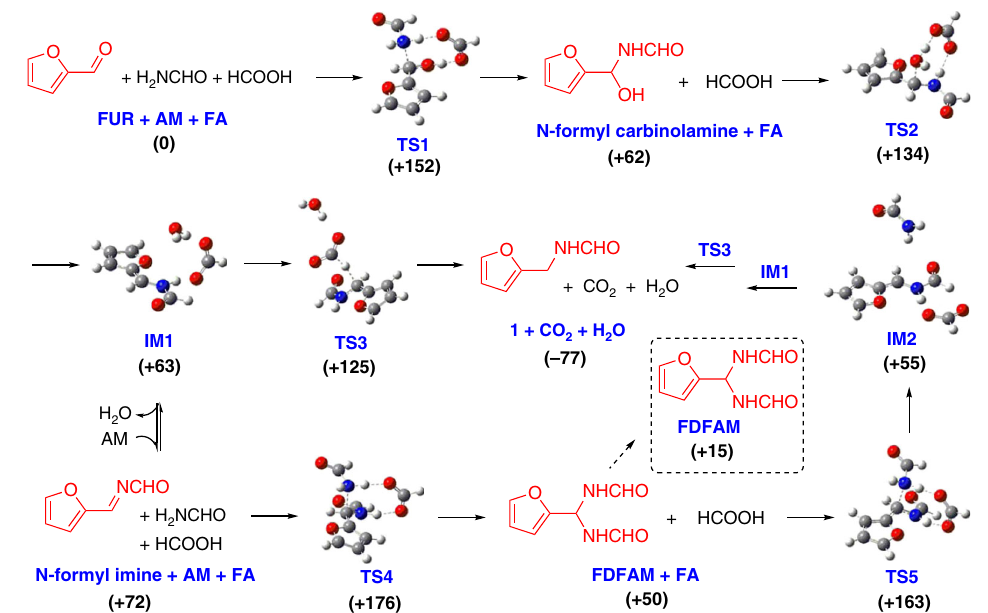
Fig. 4 Computed free energy pro fi les for amination of FUR and AM using FA to product 1 . TS: transition state, IM: intermediate. Conditions and basis set: [ T = 180 °C, B3LYP/6-311 + G(2s,2p)]. Values in parentheses are free energies (kJ mol − 1 ) based with respect to the starting energy of the three separated reactants FUR, AM, and